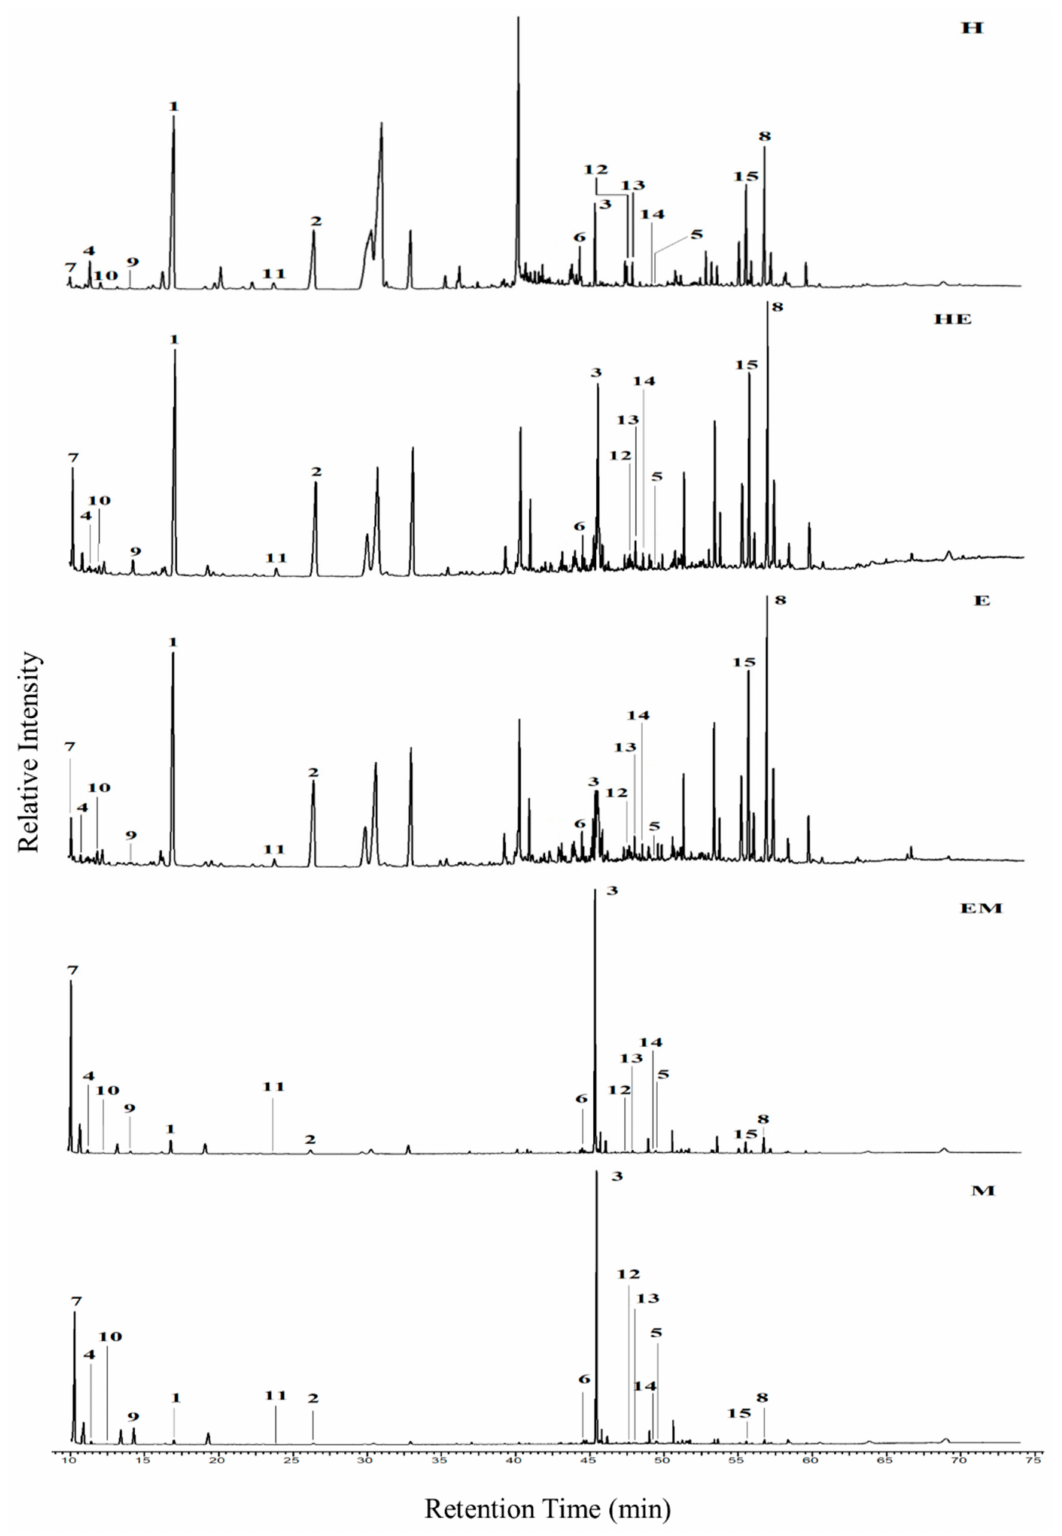
Figure 1. GC-MS chromatogram of metabolites in H, HE, E, EA and M extracts from C. nutans . Each labelled peak refers to; 1 —palmitic acid, 2 —phytol, 3 —sucrose, 4 —hexadecanoic acid, 5 —maltose, 6 —1-monopalmitin, 7 — D -glucose, 8 —stigmast-5-ene, 9 — D -gluconic acid, 10 —pentadecanoic